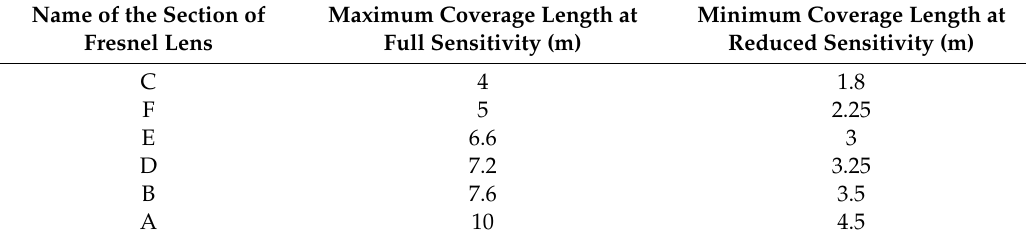
Measured coverage ranges of di ff erent regions of Fresnel lens at full and reduced sensitivity